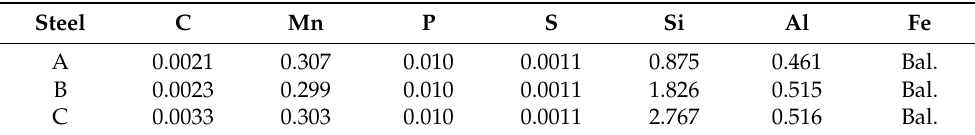
Table 1. Chemical compositions of the studied non-oriented electrical steels